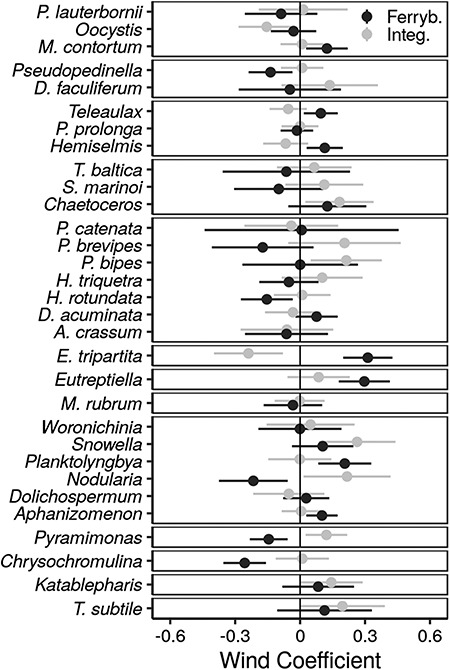
Estimated effects of the z-scored wind (\documentclass[12pt]{minimal}
\usepackage{amsmath}
\usepackage{wasysym} 
\usepackage{amsfonts} 
\usepackage{amssymb} 
\usepackage{amsbsy}
\usepackage{upgreek}
\usepackage{mathrsfs}
\setlength{\oddsidemargin}{-69pt}
\begin{document}
}{}$\overline{x}$\end{document} = 5.4 m s−1, SD = 2.1 m s−1) on the sampled log-transformed plankton biomasses (μg L−1) for integrated sampling (black) and ferrybox sampling (gray), based on the day-level GAMM analysis. The error bars are 95% CI (±1.96 × SE). The standardized effects are comparable between covariates and taxa, and directly proportional to their impact in practice on taxon-specific biomasses.